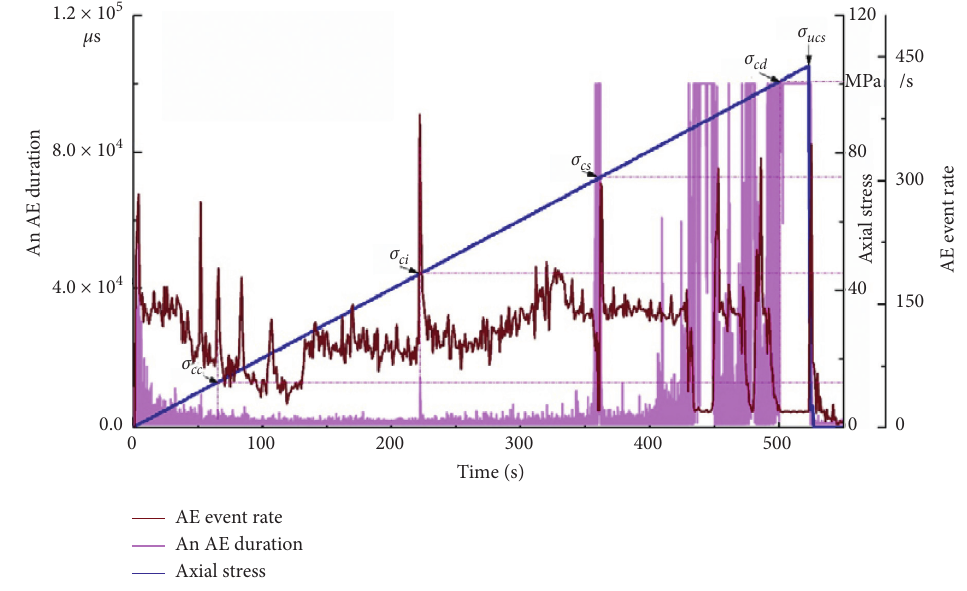
Figure 3: AE event rate, AE duration, and stress versus time